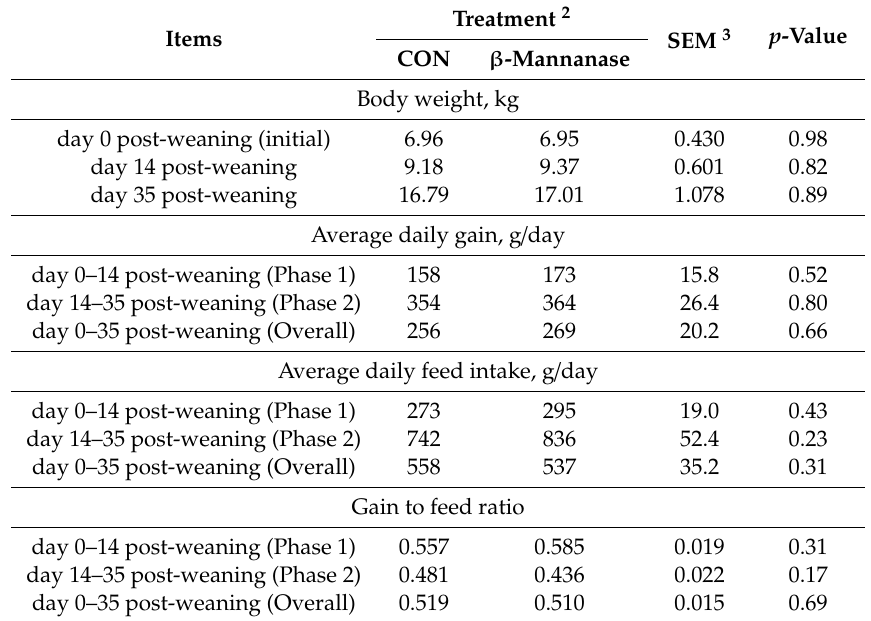
Table 2. E ff ects of dietary supplementation of β -mannanase on growth performance of weaning pigs 1 . Treatment 2 Items SEM